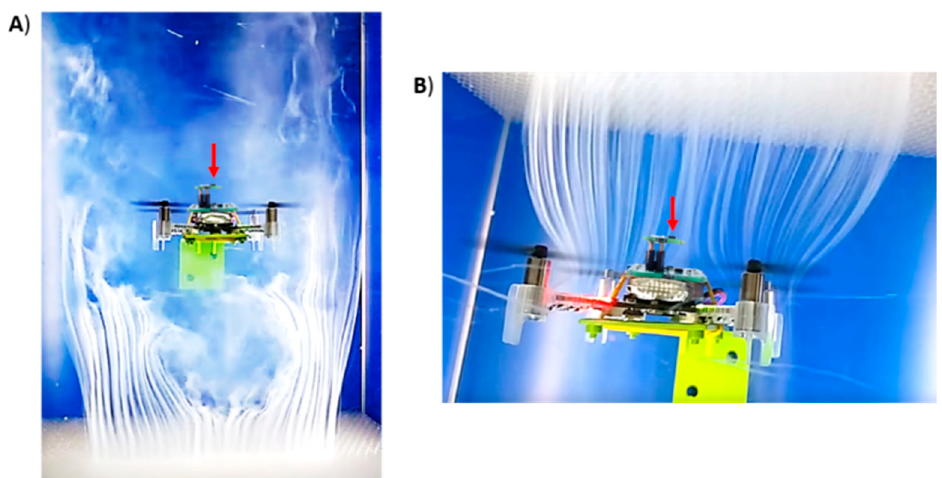
Figure 14. Aerodynamics of Crazyflie 2.0 when the four rotors are spinning, visualized using a Deskbreeze wind tunnel (Courtesy of Bitcraze AB). The drone is fixed to one of the walls of the tunnel using a 3D printed stand and dry ice fog is emitted from ( A ) below the drone or ( B ) above the drone. It shows the downwash of the propellers and how part of the fog reaches the MOX gas sensor (red arrow). The MOX deck has been overlaid to the original images for visual clarity.